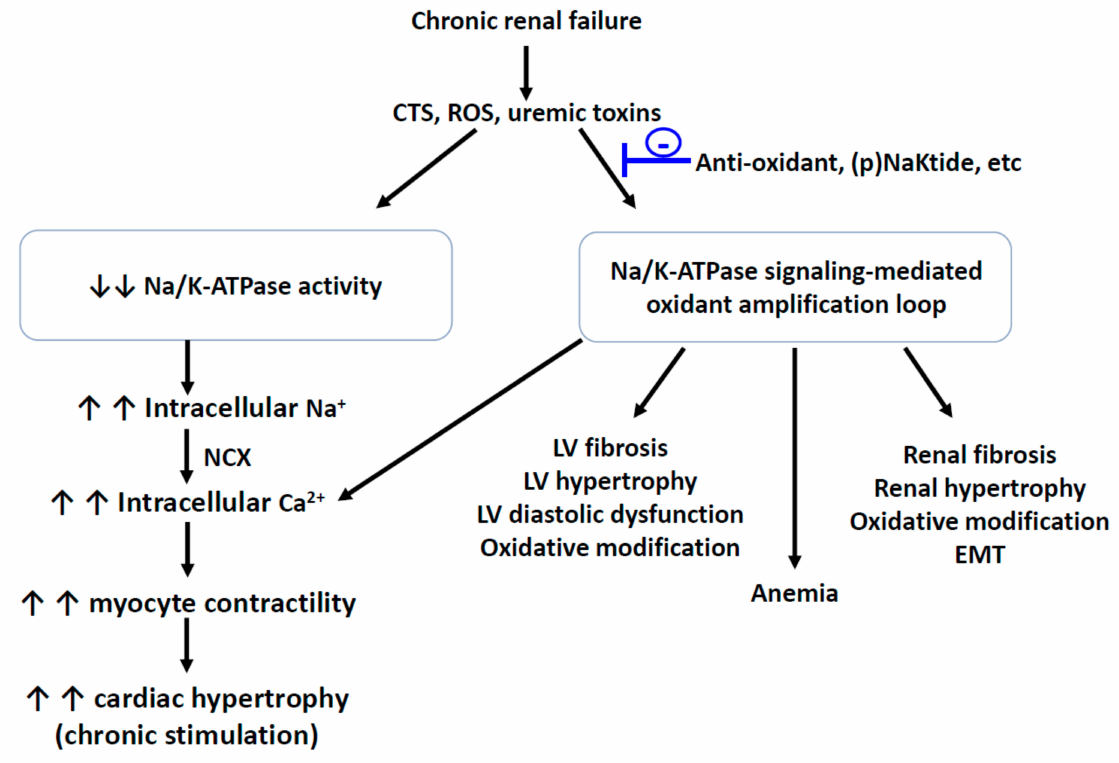
Figure 2. Schematic illustration of the proposed causes and consequences of the Na / K-ATPase signaling-mediated oxidant amplification loop. - attenuating e ff ect; CTS, cardiotonic steroids; ROS, reactive oxygen species; NCX, sodium / calcium exchanger; EMT, epithelial-to-mesenchymal